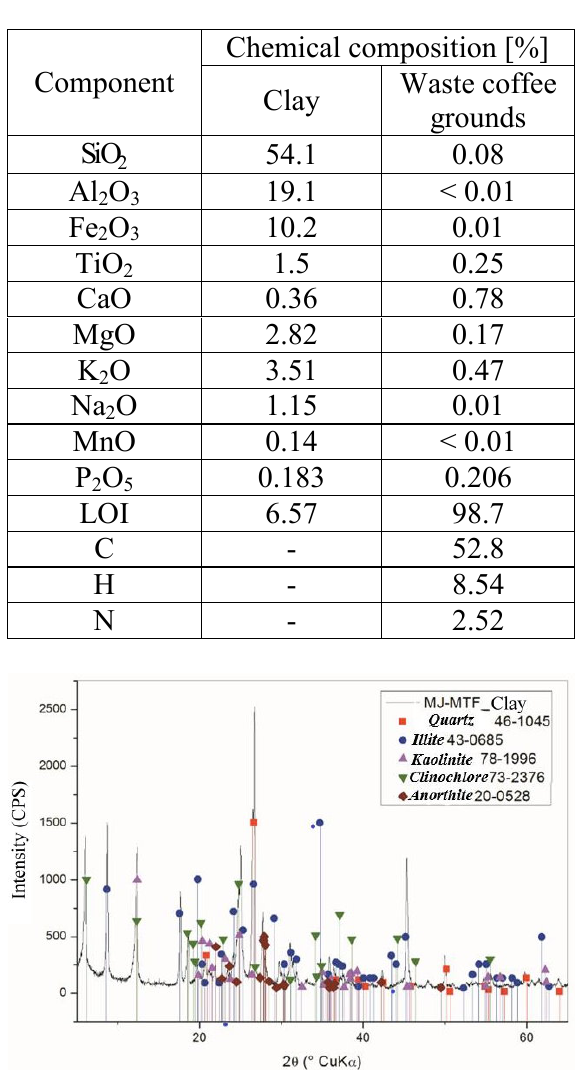
Table 2. Chemical composition of the clay and